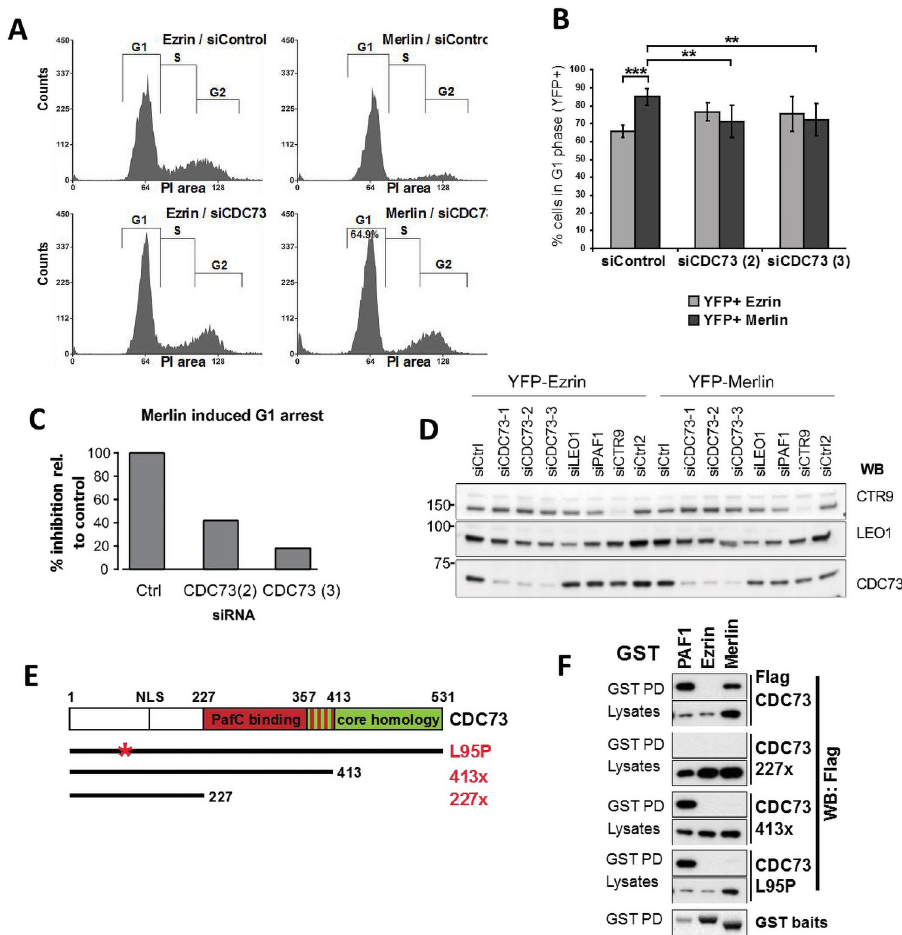
Fig 3. CDC73 is required for growth inhibition by Merlin. (A) Knockdown of CDC73 reduces Merlin-induced G1 arrest. SF1335 cells transfected with the indicated siRNAs were infected 24h later with YFP-Ezrin or -Merlin and cell cycle profiles analysed by FACS 48 hours later. Representative experiment of data shown in B. (B) Quantification of experiments as in A. Data represent the mean ± SEM of 5 independent experiments. ( � p < 0.05, �� p < 0.01, ��� p < 0.001). (C) Rescue of Merlin induced G1 arrest by CDC73 knockdown compared to control. One representative experiment shown. (D) Confirmation of CDC73 knockdown by three different siRNA oligos. Western blot analysis of protein lysates from SF1335 cells used in C confirming CDC73 knockdown. (E) Schematic of CDC73 mutants used. (F) Loss- of-function mutations in CDC73 disrupt the interaction with Merlin. GST-PAF1, -Ezrin or -Merlin were co- transfected with Flag-CDC73. Glutathione pull-downs were probed with Flag